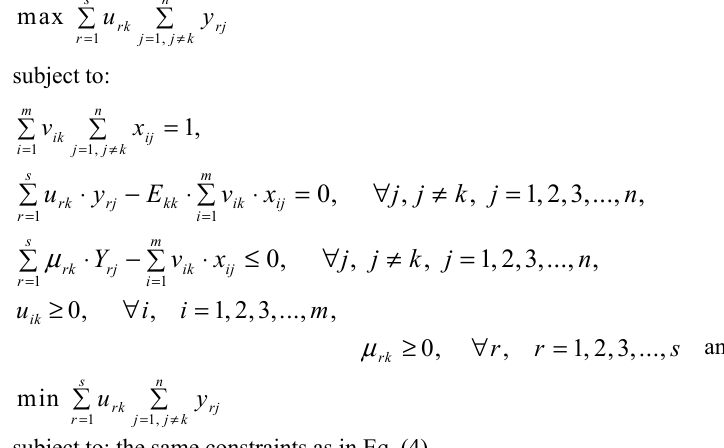
subject to: the same constraints as in Eq.